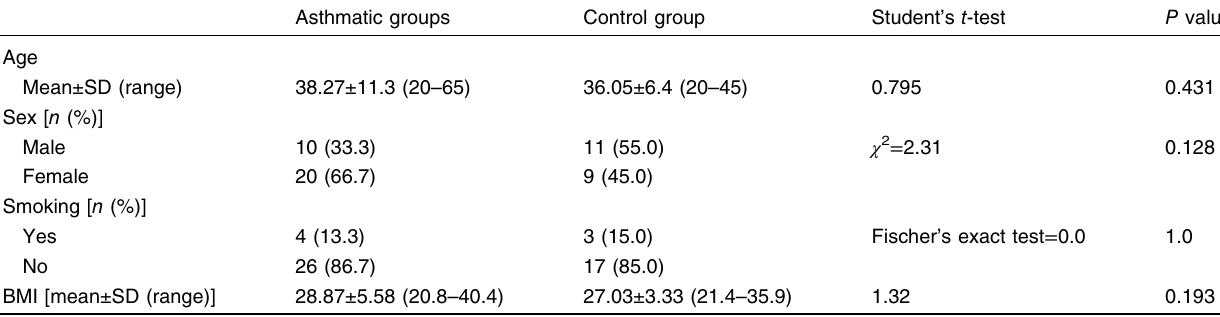
Table 1 Comparison between the asthmatic and control groups as regards personal data